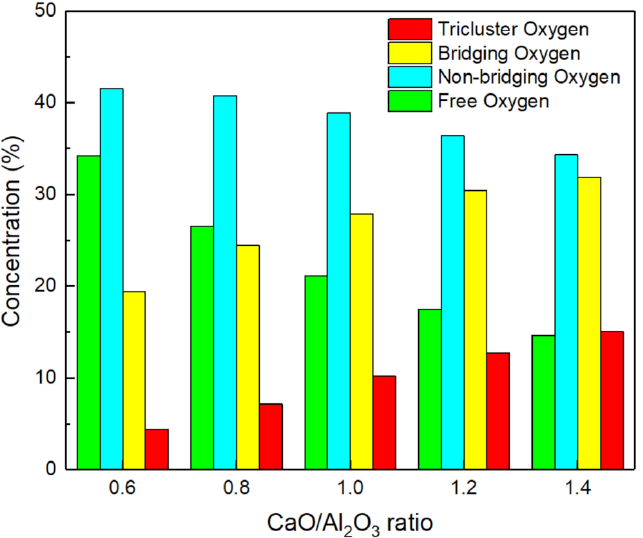
Figure 4. Evolution of different oxygen unit with various CaO/Al 2 O 3